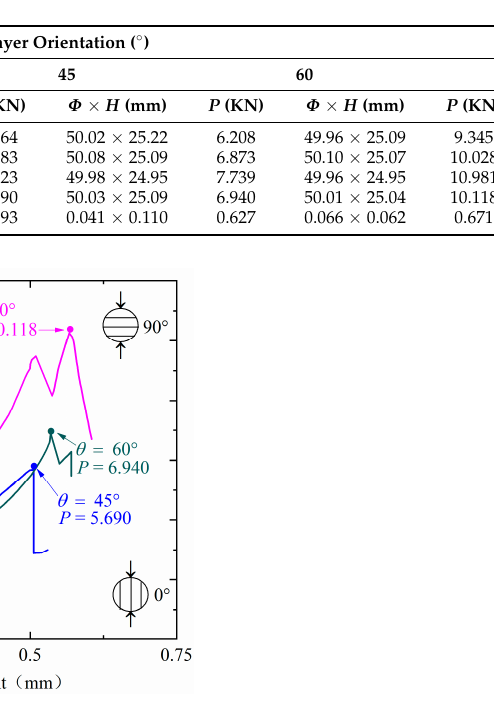
Table 1. Statistical table of Brazilian test data of continental shale. Figure 3. Schematic diagram of lamination angle loading and AE sensors’ layout.